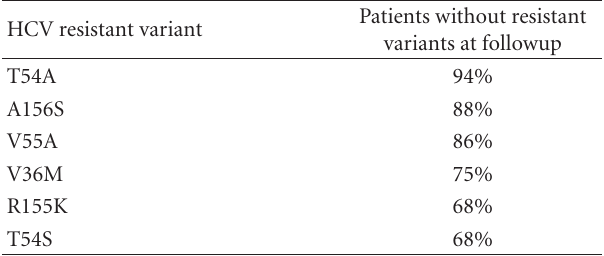
Table 1: Mutations conferring resistance to